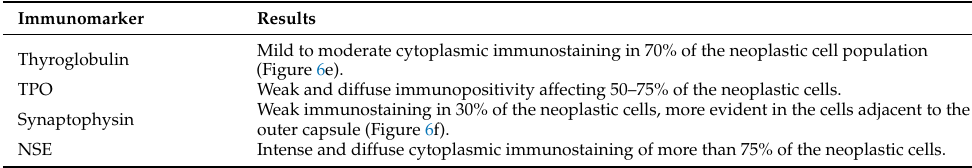
Table 5. The immunohistochemical analysis of the thyroid gland mass (Case 2).